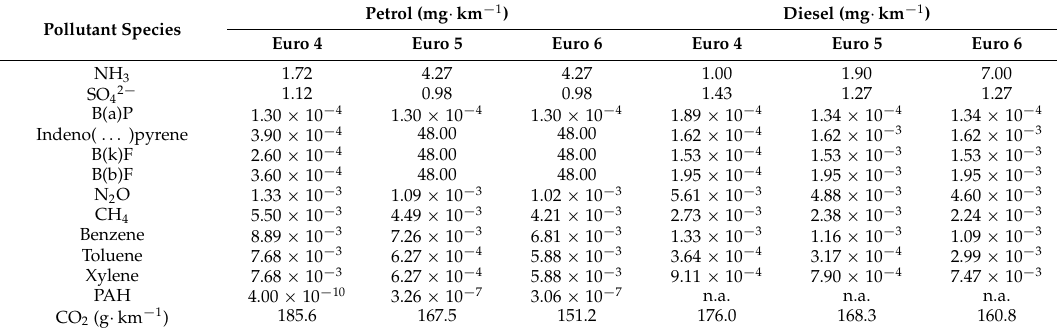
Table 5. The emission factors (EF) used for modelling the impact of non-regulated pollutants for petrol and diesel vehicles from Euro 4 to 6 (based upon [36,54,57–59]). Carbon dioxide is added to the model input, although it is not considered a pollutant. n.a.: non-available. Petrol (mg ¨ km ´ 1 ) Diesel (mg ¨ km ´ 1 Pollutant Species